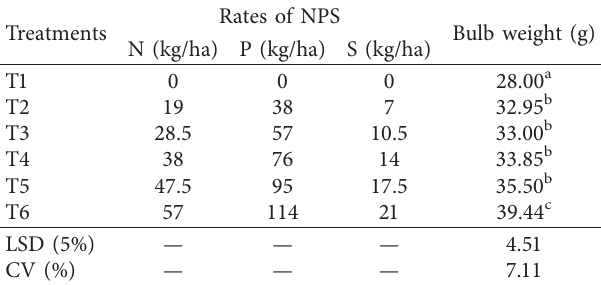
∗ Means followed by the same letter are not significantly different at 5% level of significance. Table 6: Effect of different rates of NPS fertilizer on total bulb yield of garlic. Treatments